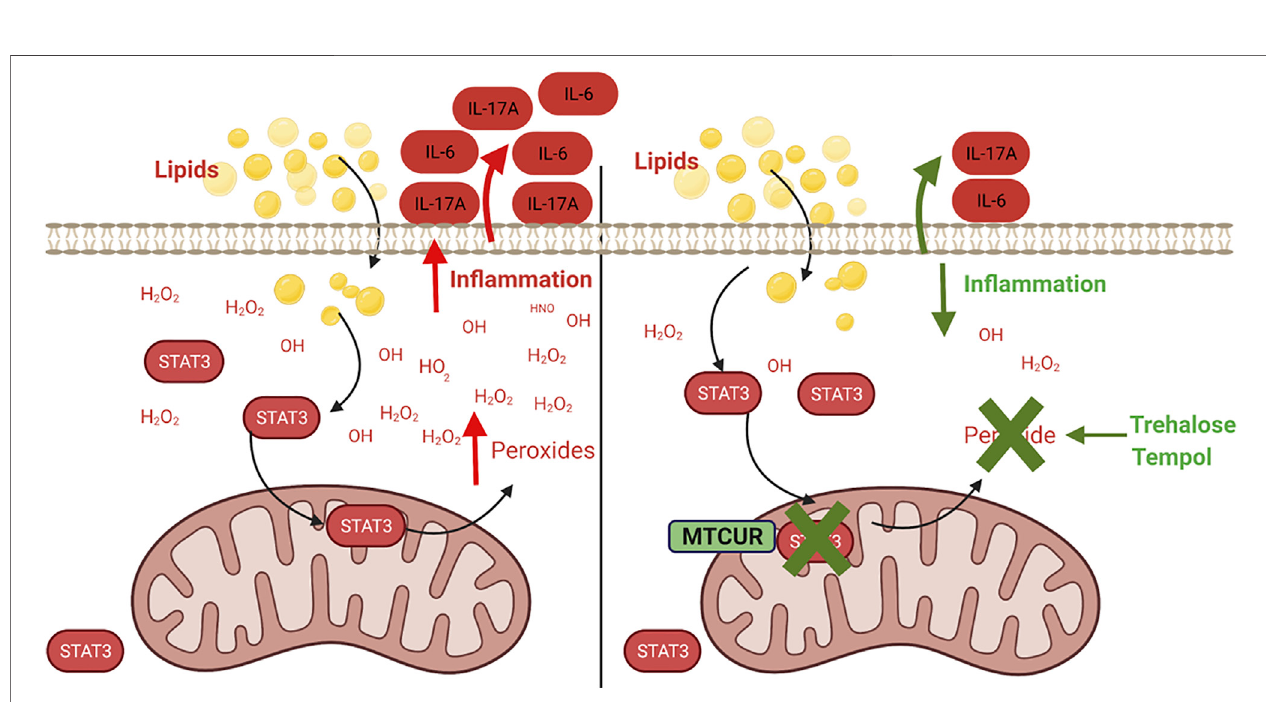
FIGURE 8 | Mitochondrial STAT3 promotes in fl ammation via ROS-dependent mechanisms. Obesity and fatty acid – induced activation and mitochondrial translocation of p-Ser 727-STAT3 (STAT3) promotes peroxide generation within the cell, resulting in the dysregulation of cellular redox balance and promoting in fl ammatory cytokine production. Preventing accumulation of mitochondrial STAT3 or scavenging of the cellular peroxides alleviates lipid-induced in fl ammation.